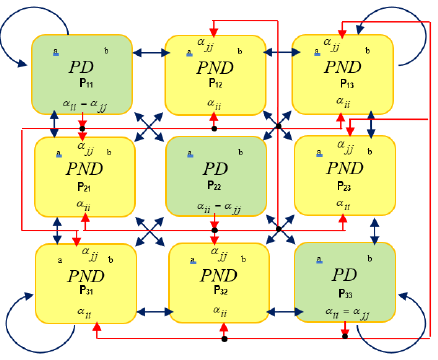
Figure 9. Systolic architecture to obtain eigenvalues.